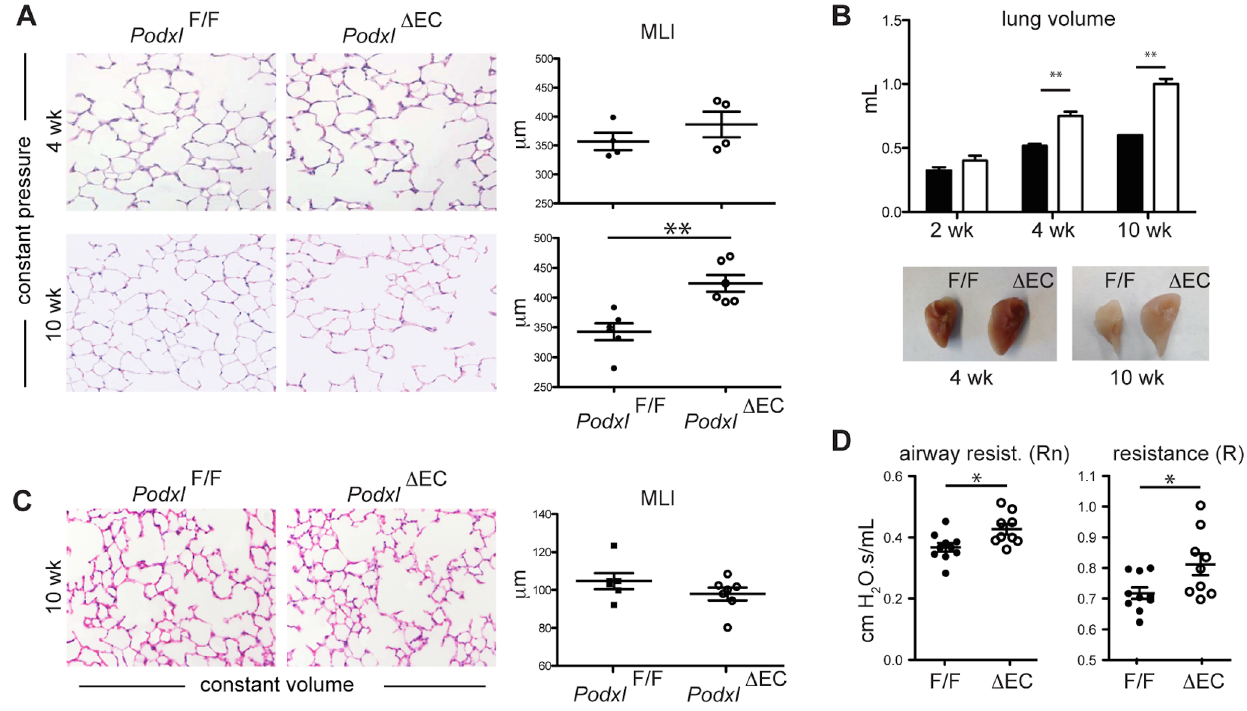
Figure 4. Deletion of vascular podocalyxin contributes to structural and functional changes in the lung. ( A ) H&E stained sections of lungs inflated to 25 cm H 2 O with open thoracic cavity from Podxl F/F and Podxl D EC mice obtained at 4 weeks and 10 weeks post-natal. Loss of podocalyxin results in increased mean linear intercept (MLI) at 10 weeks of age. The MLI values were determined by computer-assisted image analysis (n=6 mice per genotype). ( B ) Mean lung volumes of Podxl F/F and Podxl D EC mice at 2, 4 and 10 weeks (n=4–6 mice per genotype). Representative images of inflated lungs at 4 and 10 weeks are shown below the graphs. ( C ) H&E stained sections of lungs inflated with constant volume with closed chest wall from adult Podxl F/F and Podxl D EC mice (n=6 mice per genotype). ( D ) Resistance measurements from primewave-8 (Rn) and snapshot (R) perturbation. *Significantly different with P , 0.05 by Student’s t test; **Significantly different with P , 0.01 by Student’s t test at each time point. The error bars represent the